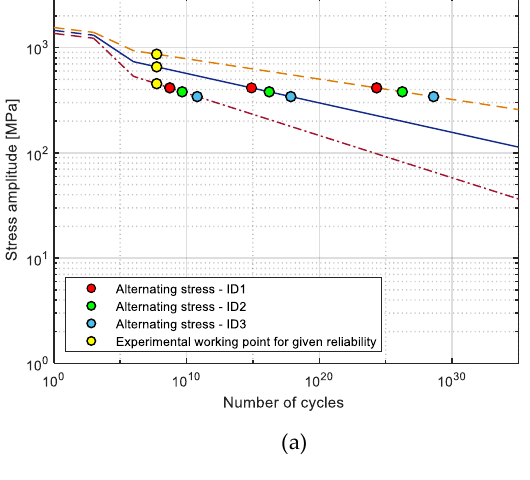
Table 5. The estimated allowable number of cycles for the considered curvature radii pairs and reliability levels.